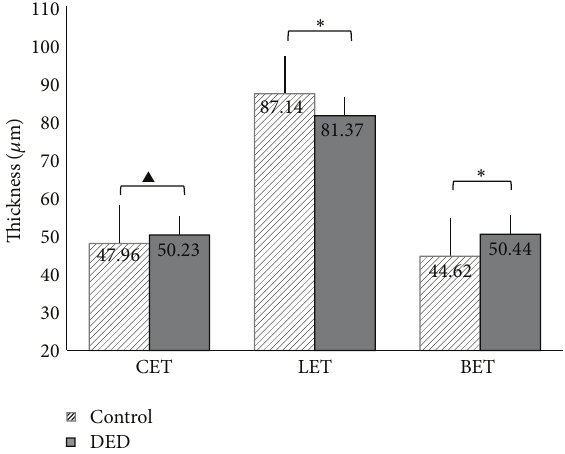
Figure 2: Comparison of CET, LET, and BET data between DED and control group. ∗ represents a significant difference between the indicated groups, 𝑃 ≤ 0.05 ; 󳵳 represents no significant difference. ANOVA with Tukey’s post hoc